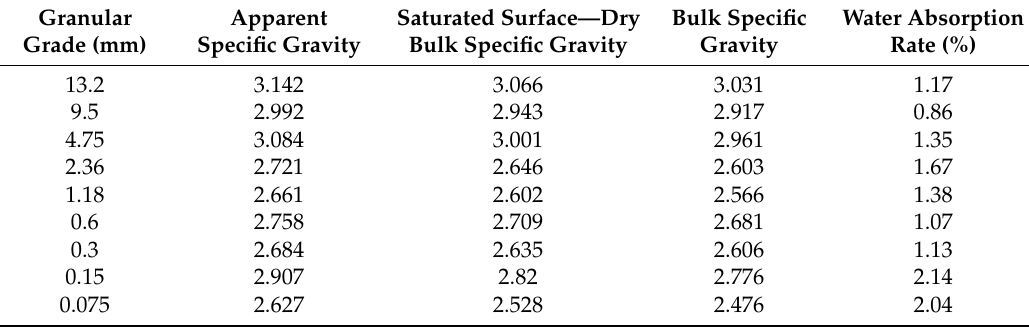
Table 3. Physical properties of aggregate.